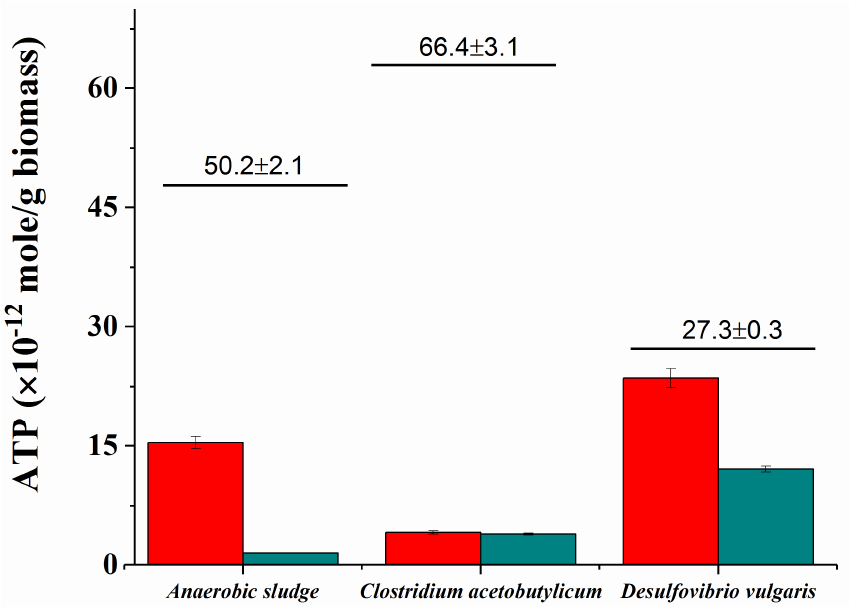
Figure 2. Assessment of the energy status by intracellular ATP concentration in the components of artificial anaerobic consortium in the methanogenesis of biomass of Chlorella vulgaris microalgae for 10 days in the absence ( ) and presence ( ) of DBTO 2 in the cultural medium. The lines indicate the initial levels of intracellular ATP concentrations of corresponding cells.